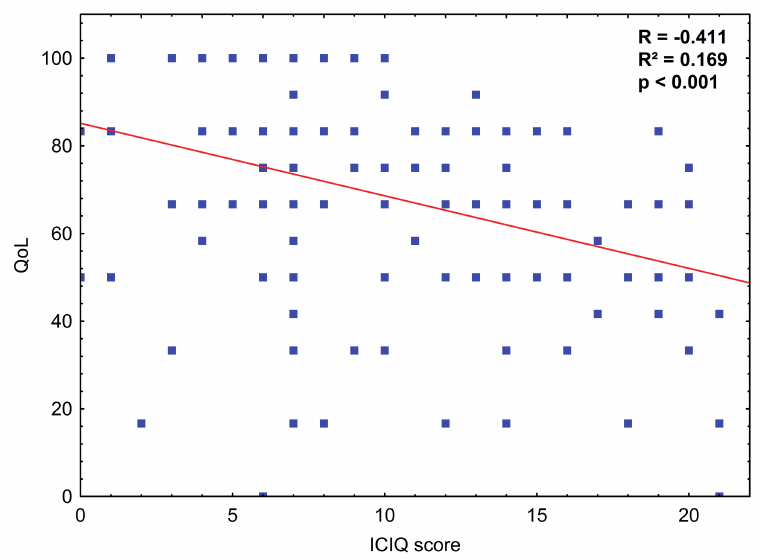
figure 2 - Impact of patient’s IcIQ-sf score on health-related quality of life based on EORTc QLQ-c30 global health status using spearman’s rank correlation. A p value <0.05 was considered statistically significant (QOL=quality of